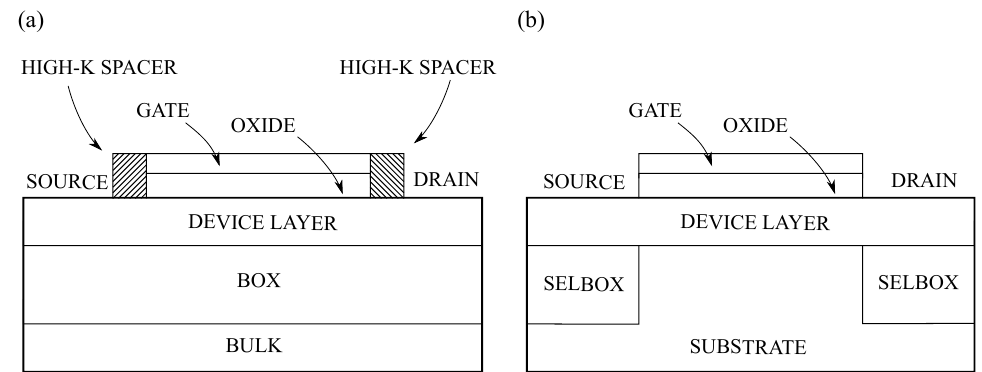
Figure 11. Cross-sectional view of: ( a ) Single Gate junctionless transistor (SGJLT) with high-k spacers. ( b ) SGJLT with